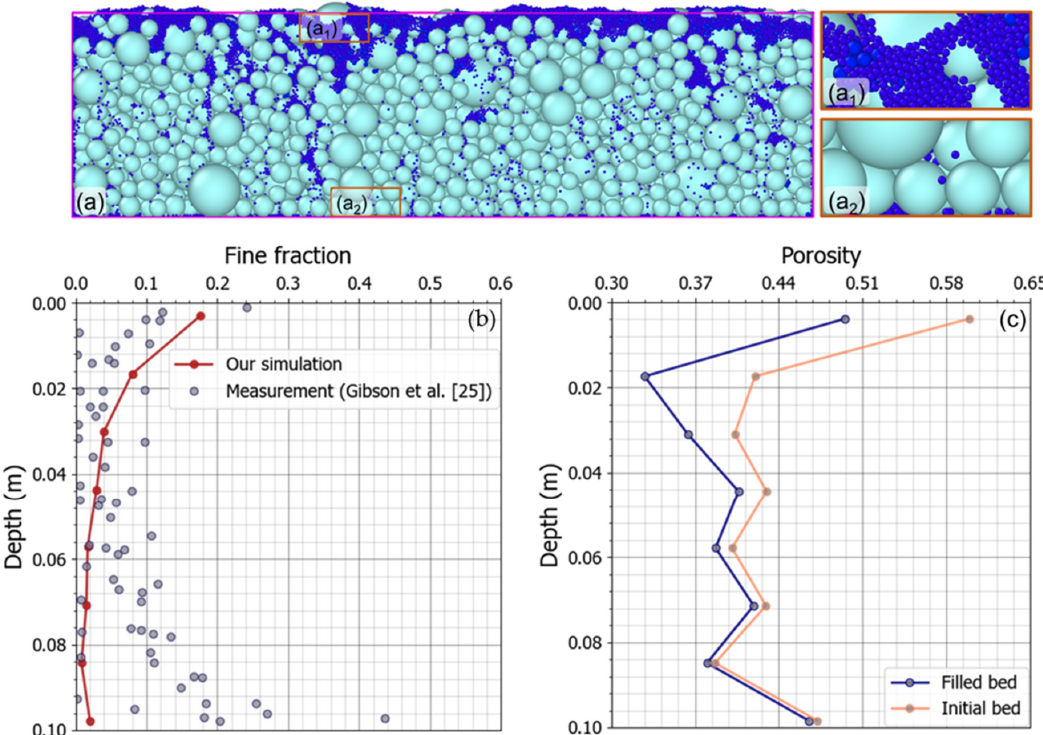
Figure 7. ( a )—Structure of bed sediments at a cross‐section along the channel at the final computational step ( b )—Fine fraction distribution at the end of simulation; and, ( c )—Bed porosity distribution along the depth at the beginning and the end of the computation time.